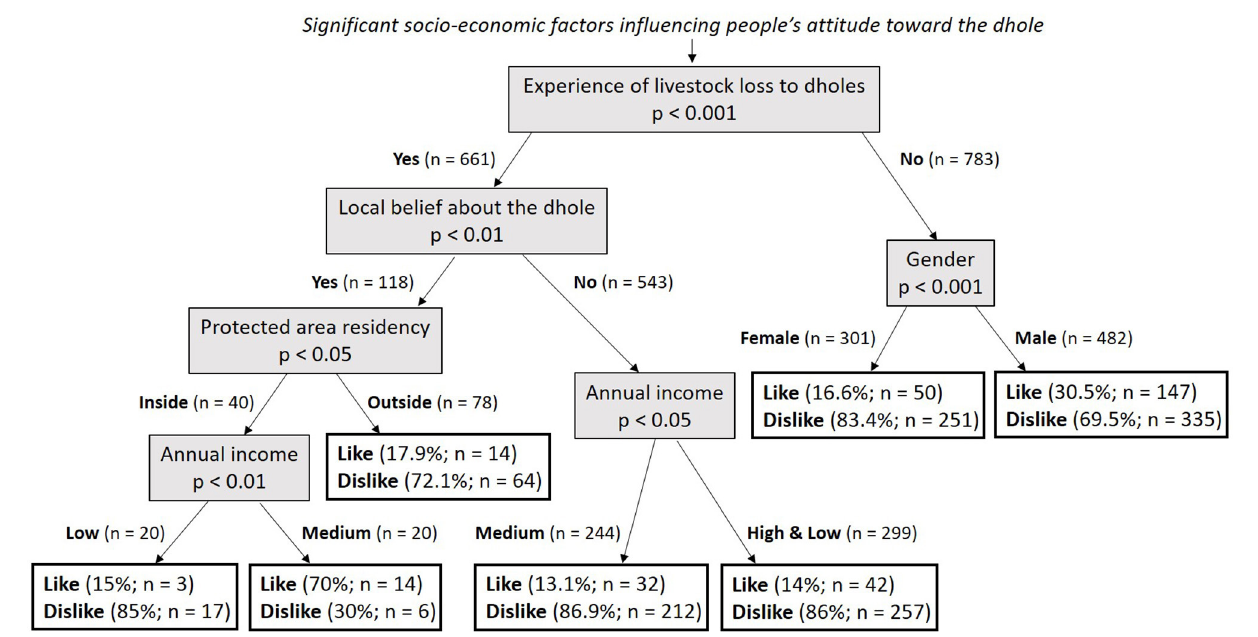
FIGURE 2 | Conditional inference tree showing “experience of livestock loss to dholes” as the primary significant predictor of local people’s attitude toward the endangered dhole ( Cuon alpinus ) in Bhutan. Statistical significance of the tree split is indicated by p